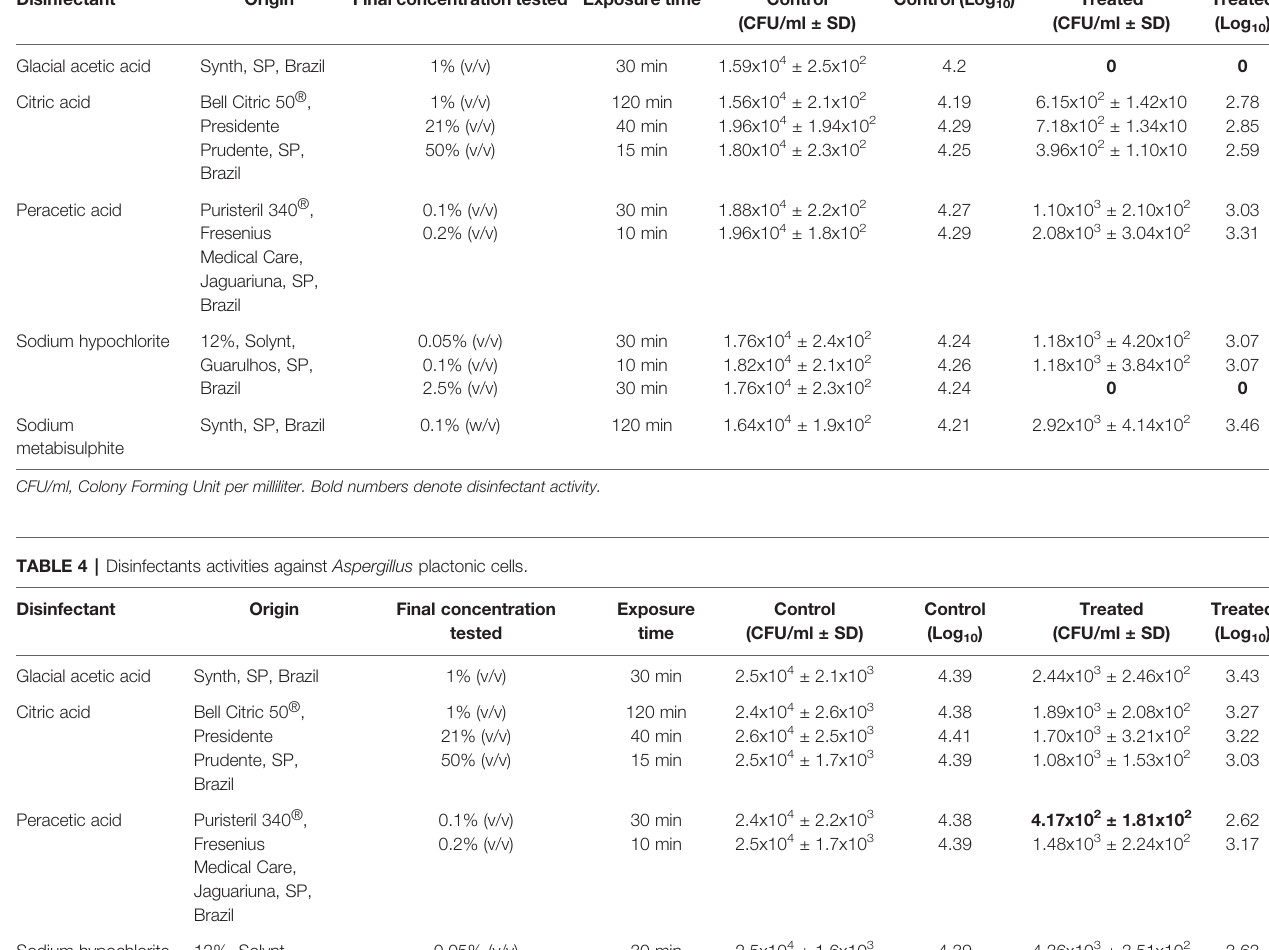
TABLE 3 | Disinfectants activities against Fusarium planctonic cells.